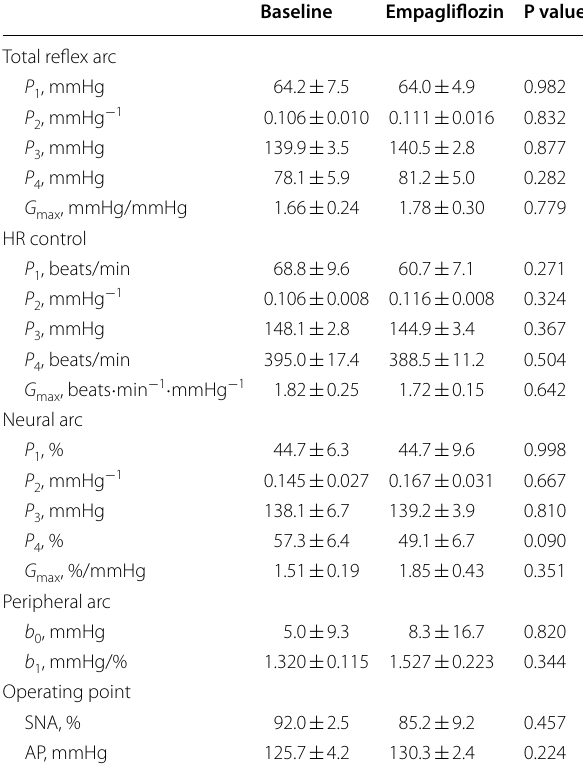
Table 2 Parameters relating to baroreflex open-loop static characteristics during baseline and T3 periods obtained in the empagliflozin